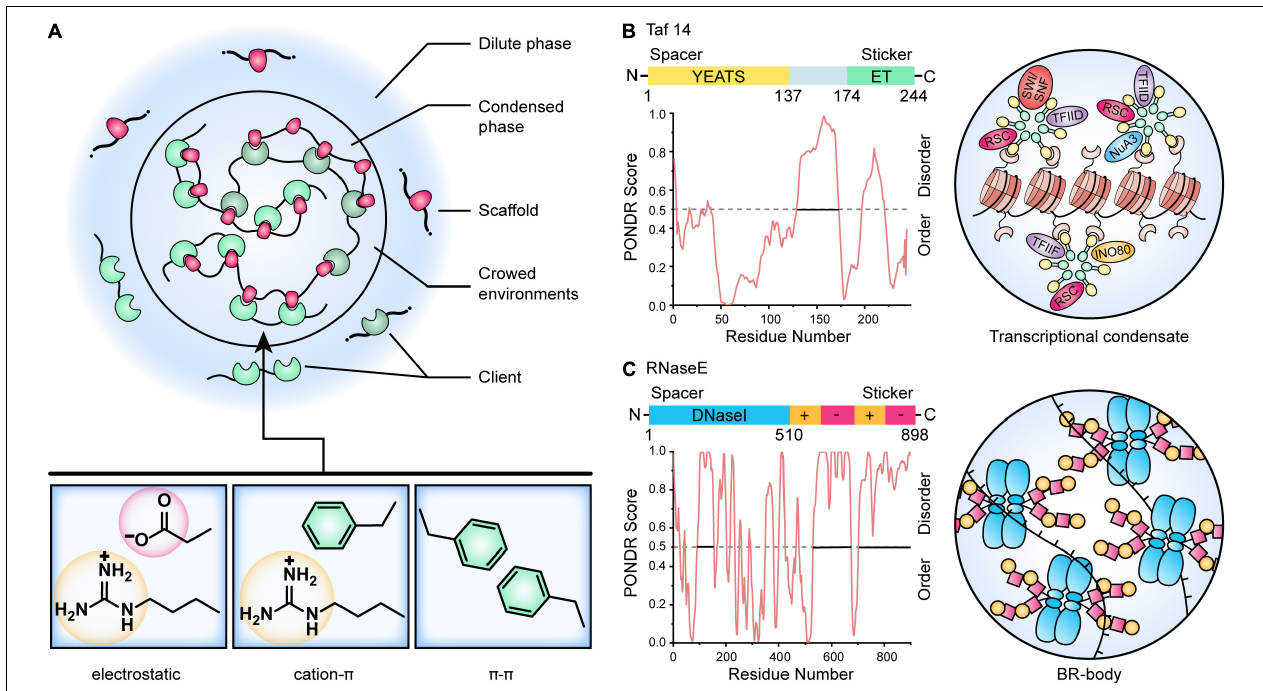
FIGURE 2 | A model for the control of biomolecular condensates. (A) Multivalent interactions that drive LLPS. Scaffold molecules (red) that undergo LLPS are in stoichiometric excess (often in a crowding environment) and enriched for defined modular domains or intrinsically disordered regions. Client molecules (green) are recruited by binding to the free cognate sites in the scaffold. The critical scaffold/client or scaffold/scaffold interactions include electrostatic, cation- π , and π - π contacts. (B) Model of yeast Taf14-mediated transcriptional condensate. The Taf14 protein contains two main domains, an N-terminal YEATS (Yaf9, ENL, AF9, Taf14, Sas5) domain (yellow) that recognizes lysine acylation modification, as well as a C-terminal ET domain (green) that is reported as a protein-protein interaction domain and recognizes peptide substrates. The disordered regions of Taf14 were predicted by PONDR (Xue et al., 2010). Taf14 works as a scaffold protein that promotes phase separation of condensates and concentrates different transcriptional machinery to form Taf14-containing complexes, thereby enhancing transcription efficiency (Chen et al., 2020). (C) Model of Caulobacter RNase E BR-body assembly. The domain architecture for the RNase E protein is shown, and the disordered regions were predicted by PONDR (Xue et al., 2010). The N-terminal catalytic DNaseI domain (blue) and C-terminal disordered regions (yellow and red) are highlighted. The disordered regions contain positive-charged patches (Arg-rich RNA binding sites, yellow) and negative-charged patches (facilitating multivalent interactions with RNA, red), causing self-assembly of BR-bodies into condensates through electrostatic interactions (Al-Husini et al., 2018,